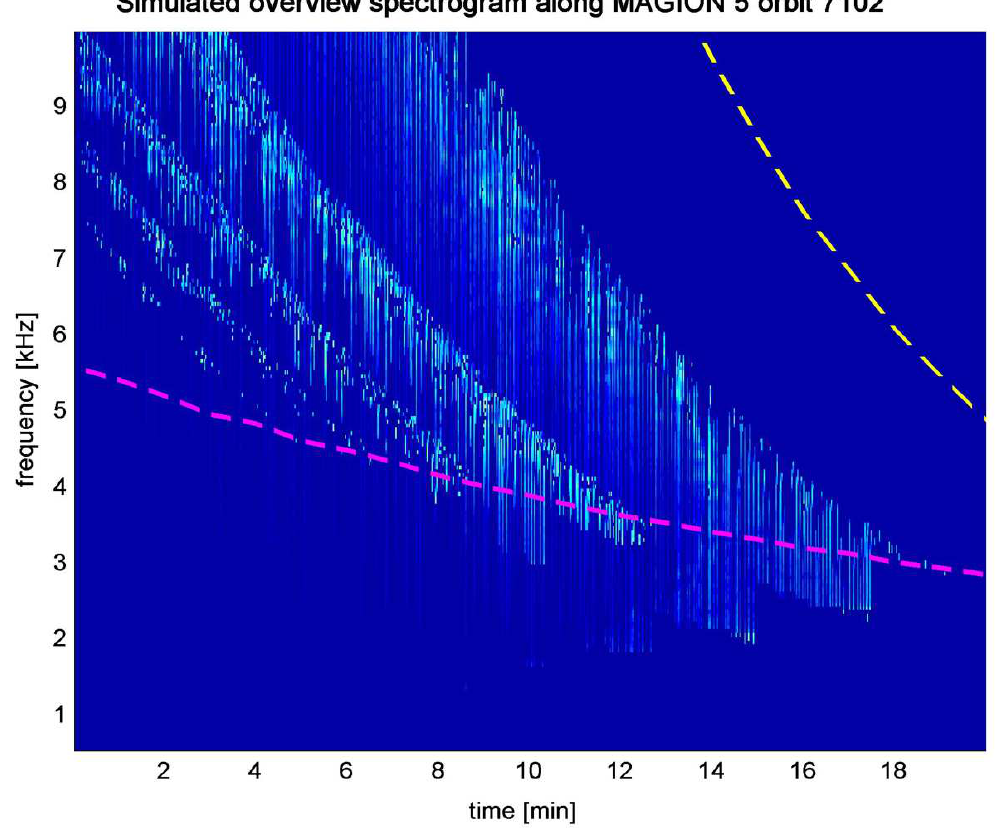
Fig. 12. Example of simulated overview spectrogram. Magenta dashed line indicates the LHR frequency along the satellite path. The yellow dashed line corresponds to a quarter of the equatorial electron cyclotron frequency on the current L-shell and serves as an additional reference frequency on the